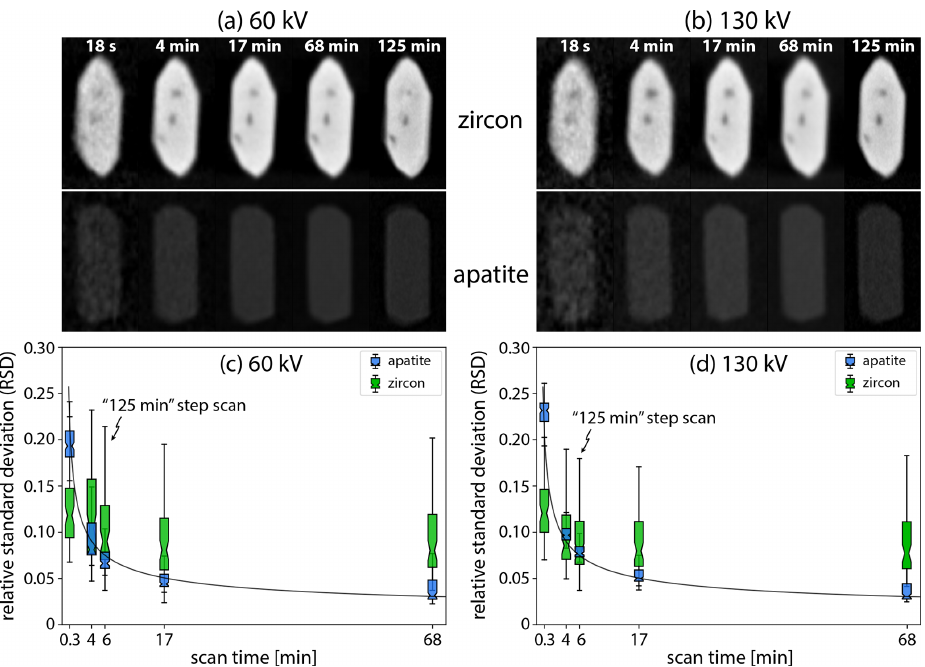
Figure 7. Slices of selected grains (a, b) and grayscale relative standard deviations (RSDs) of all analyzed apatite and zircon grains (c, d) at different scan times for 60 and 130kV scans. Slices are given at the same contrast settings, showing the difference in grayscale value between apatite and zircon. Scans of 18s, 4, 17, and 68min are processed at a reduced resolution (5.7µm) whereas 125min scans are processed at full resolution (2.1µm). Image quality and signal-to-noise ratio improve with longer scan times, and graphs of 1 / for reference (gray lines). For our instrumental and scan parameters, we did not see significant improvements in signal-to-noise ratio past 17min.